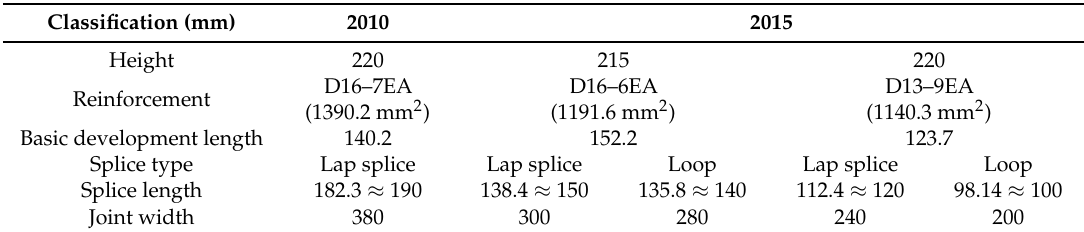
Table 7. Optimal design of the